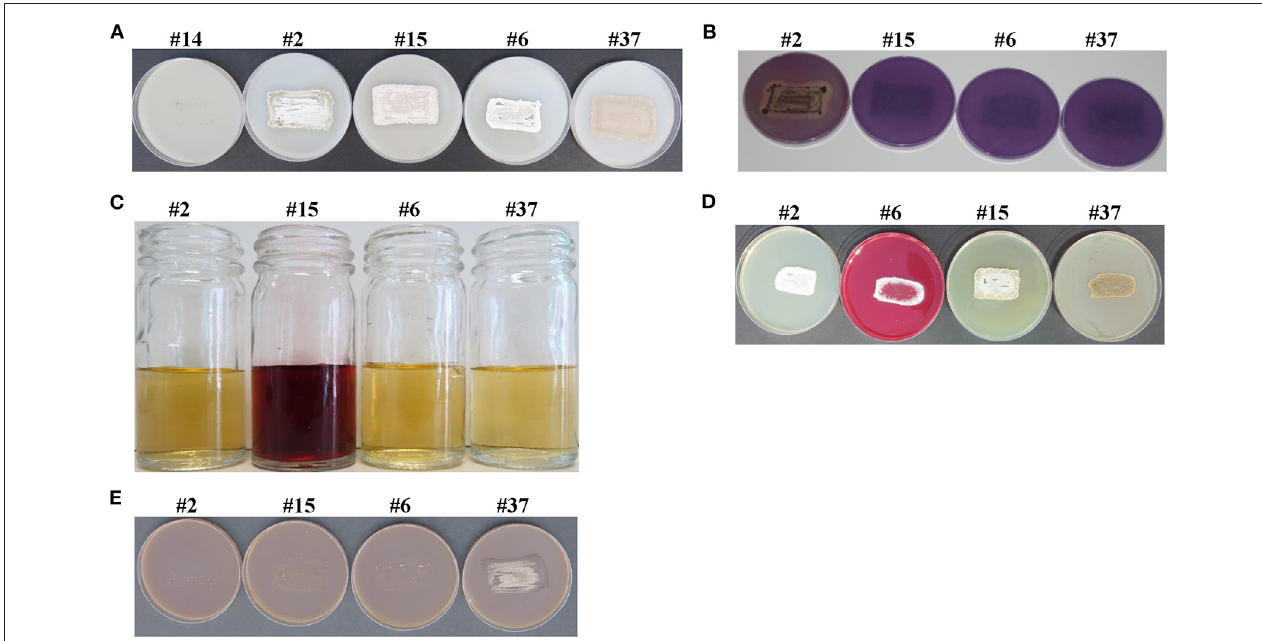
FIGURE 1 | Salinity tolerance and in vitro plant growth-promoting characteristics of selected actinobacterial isolates. Selected actinobacterial isolates possessing (A) salinity tolerance; (B) the solubilization of P; the production of (C) IAA; (D) Put; and (E) ACCD. In (A) , actinobacteria #2, #15, #6, and #37, but not #14 (control), were considered as salt-tolerant isolates due to growth and heavy sporulation on inorganic salt starch agar (ISSA) supplemented with 8% NaCl. Actinobacterial strain #14 was used as a control isolate. In (B) , isolates were tested on Pikovskaya’s agar medium amended with rock phosphate (RP) and bromophenol blue; and the production of clear zone surrounding the colony of isolate #2, but not #15, #6, or #37 was used as an indicator of P-solubilization. In (C) , the addition of Salkowski reagent to cultures grown in inorganic salt starch broth (ISSB) amended with L-tryptophan; and the formation of red color in isolate #15, but not #2, #6, or #37, indicated the production of the auxin, IAA. In (D) isolates were tested on Moeller’s decarboxylase agar medium (MDAM) amended with L-arginine-monohydrochloride; and the change from yellow to red color of the phenol red in isolate #6, but not #2, #15, or #37 indicated the production of the polyamine (PA), Put. In (E) , isolates were inoculated on N-free Dworkin and Foster’s salts minimal agar medium amended with ACC; where growth and heavy sporulation in isolate #37, but not #2, #15, or #6, indicated the efficiency to utilize ACC and the production of ACCD. P, phosphorus; IAA, indole-3-acetic acid; Put, putrescine;